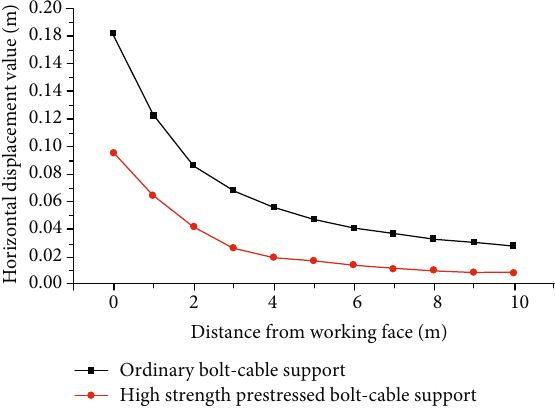
Figure 17: Stress condition of the